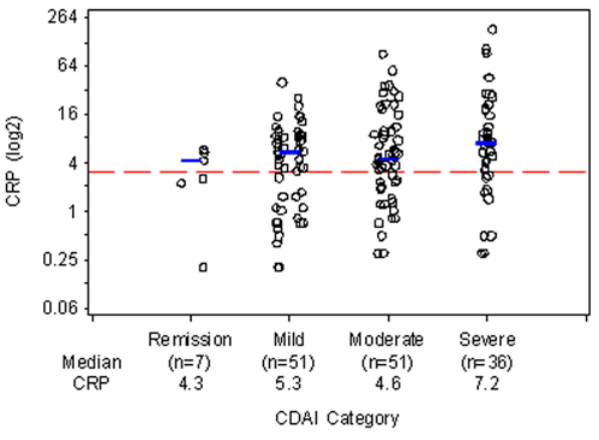
Figure 3. CRP Levels by Disease Activity as Determined by CDAI. CRP (log2) values are shown within each CDAI category. CRP levels and CDAI were determined at the same clinic visit. Blue lines denote location of median. The dotted reference line is at CRP=3 mg/L.